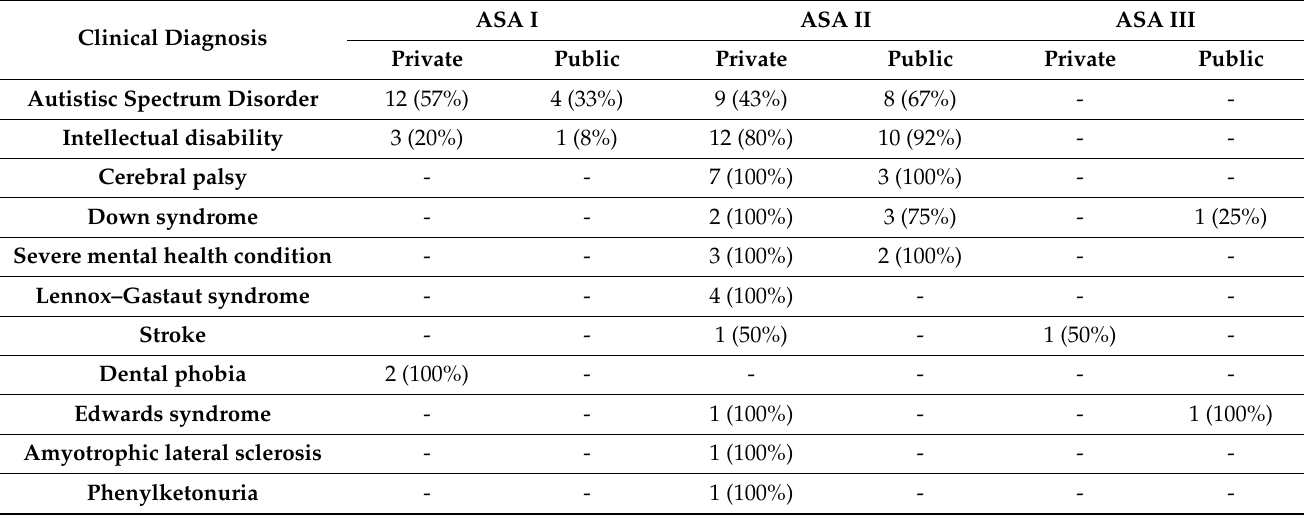
Table 4. Profile of PSN considering pre-operative GA risk